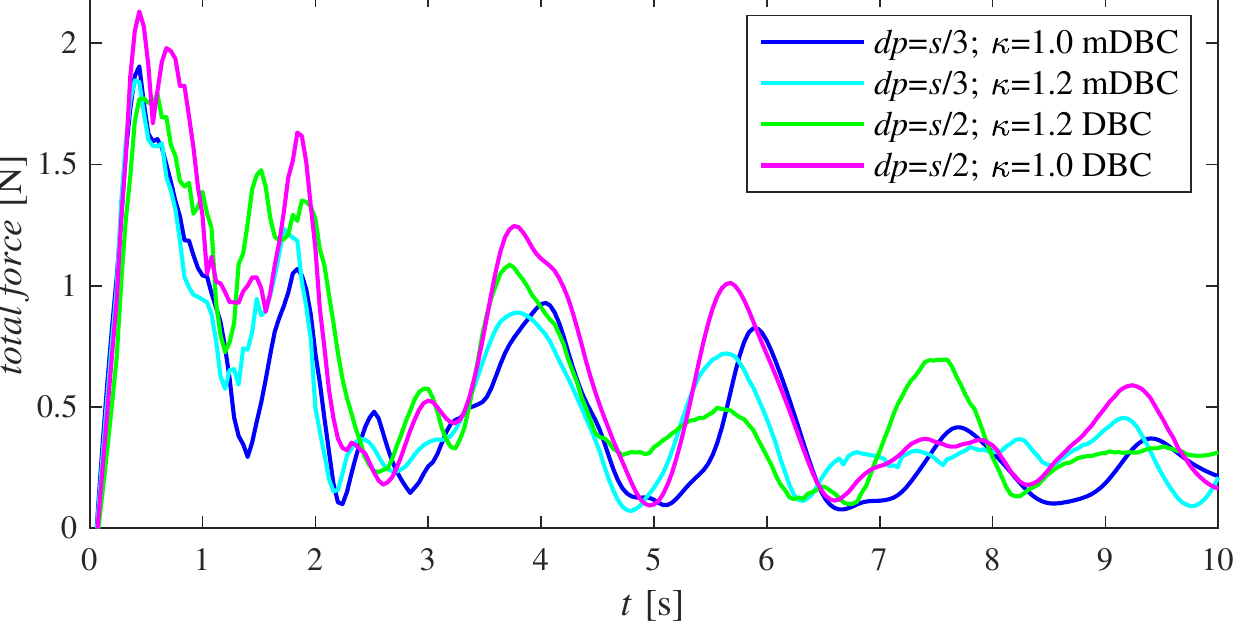
Figure 12. Variation in time of the total force exerted by the fluid on the downstream